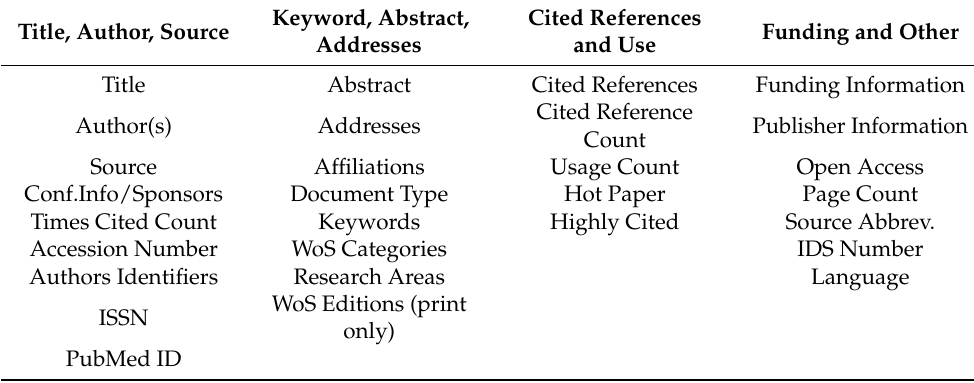
Table 1. Web of Science core